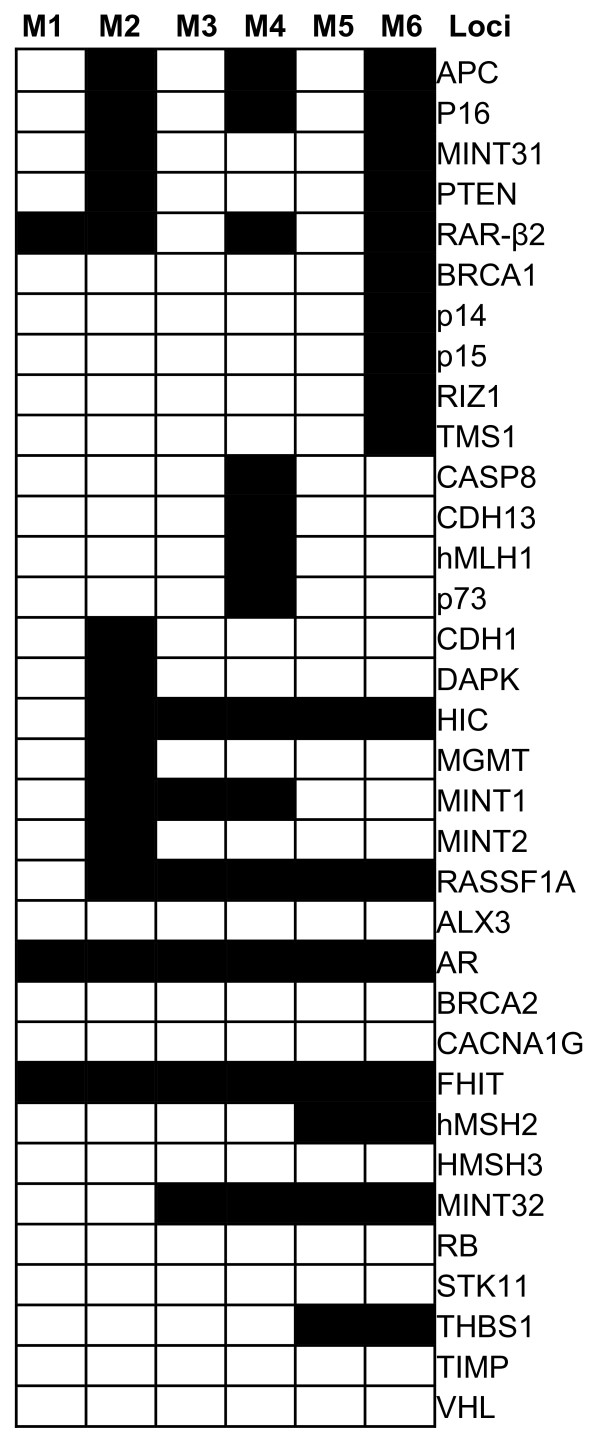
Methylation status of the 34 gene loci in the three types of gynecologic cancer. (■) Presence of methylated alleles. (□) Absence of methylated alleles.